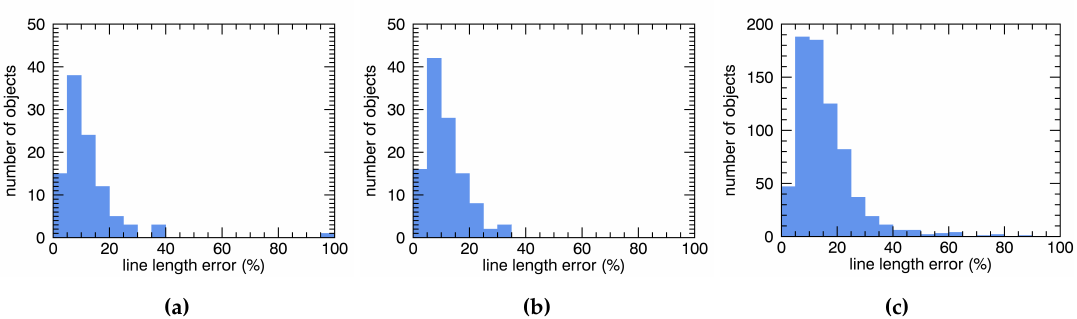
Figure 10. LKF length error distribution (in percent of the total line length). ( a ) R 0 : N = 129; ( b ) R + N = 136; ( c ) R 10 : N = 1411.